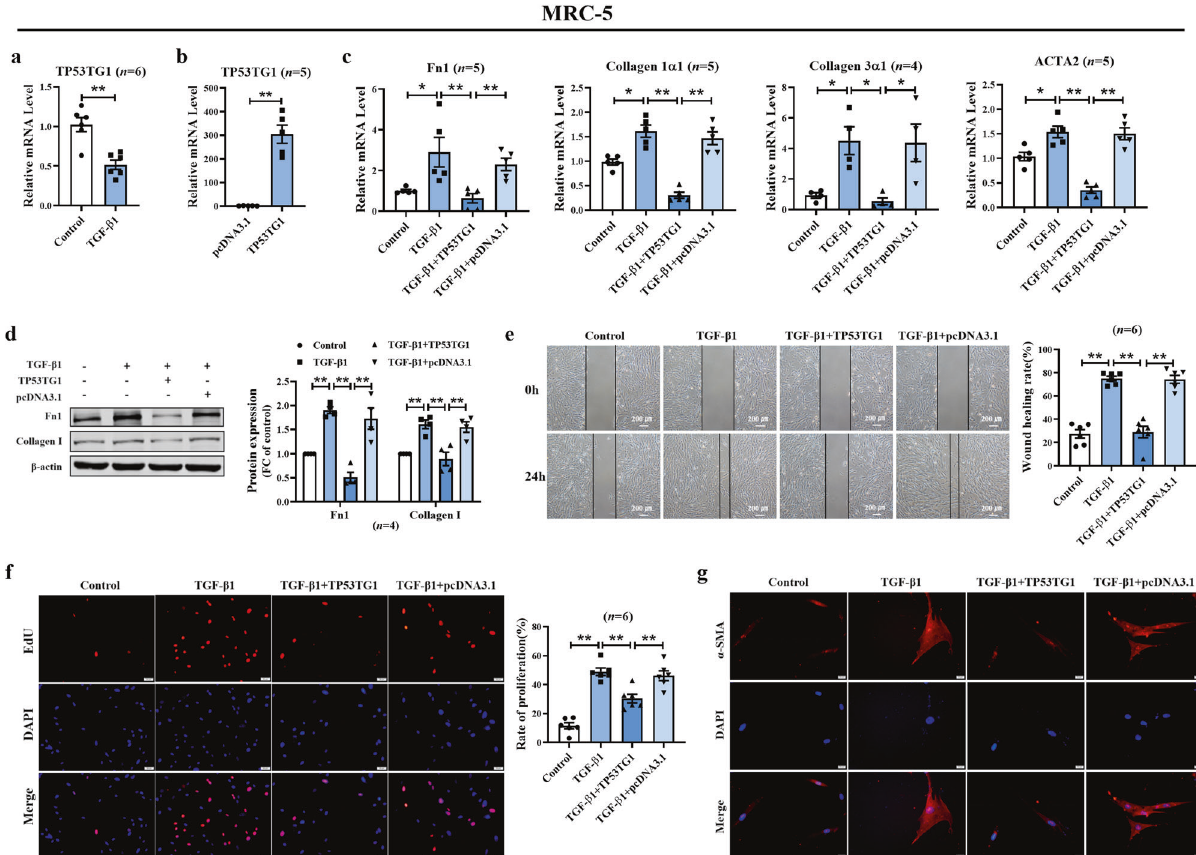
Fig. 4 Effects of TP53TG1 on human lung fi broblasts (MRC-5). a After TGF- β 1 induction, TP53TG1 was down-regulated measured by qRT- PCR. b TP53TG1 plasmid overexpression ef fi ciency was veri fi ed by qRT-PCR. c The suppression of relative mRNA expression of fi brosis markers by TP53TG1 was examined by qRT-PCR. d TP53TG1 showed noticeable inhibitory effects on TGF- β 1-induced upregulation of Fn1 and Collagen I protein levels. e , f TP53TG1 hindered the migration and proliferation of MRC-5 cells induced by TGF- β 1 detected by wound healing (bar